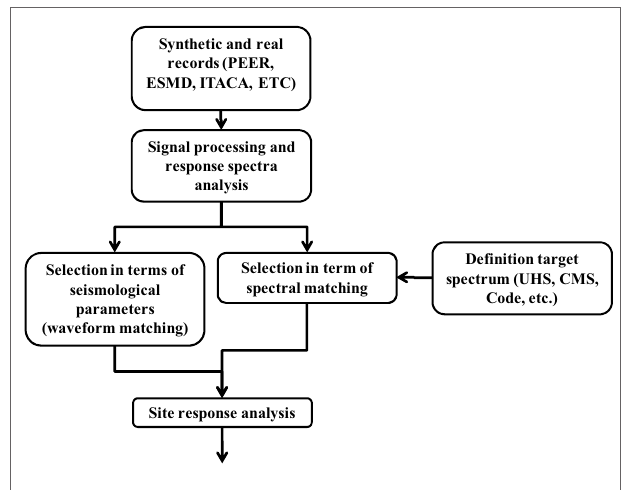
FigUre 1 | Flow chart for selecting accelerograms for use in engineering analysis and design